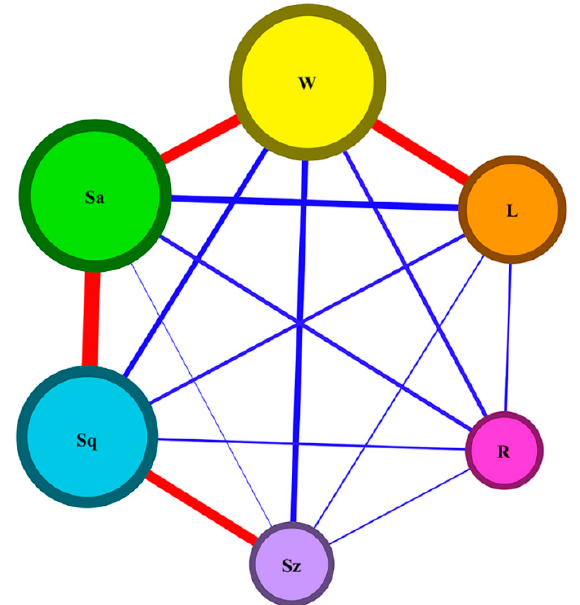
Figure 6. Analysis of relations between the cutting characteristics of W , L , Sa , Sq , Sz , and R . Red and blue lines indicate that their relation strength is large and small, respectively. The thickness of the line indicates the value of the correlation coefficient of the two characteristics and the size of circle indicates the sum of coefficients related.